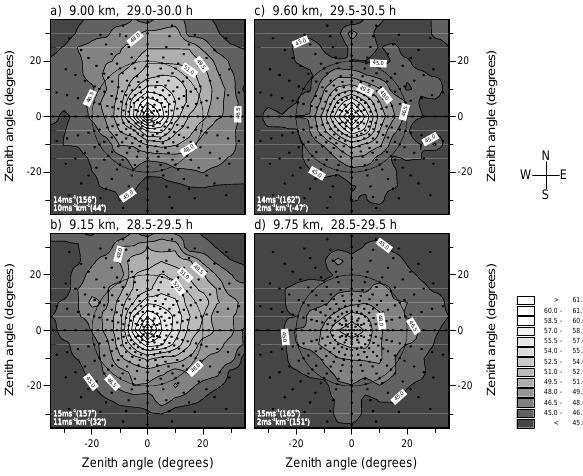
Fig. 4. Horizontal maps of echo power distribution patterns with the MU radar averaged over 1 hour with 320 directions for four tropospheric heights (9.00, 9.15, 9.60 and 9.75km). Such studies are difficult to perform at stratospheric heights due to the loss of sensitivity of the radar when the number of beam directions is large. (a and (b show a skew of the power pattern in the direction of the wind shear (about 10 ms − 1 km − 1 ). The maximum of echo power is observed overhead. In some azimuths, the isotropic level is not observed before 30 ◦ off the zenith (after Worthington et al.,